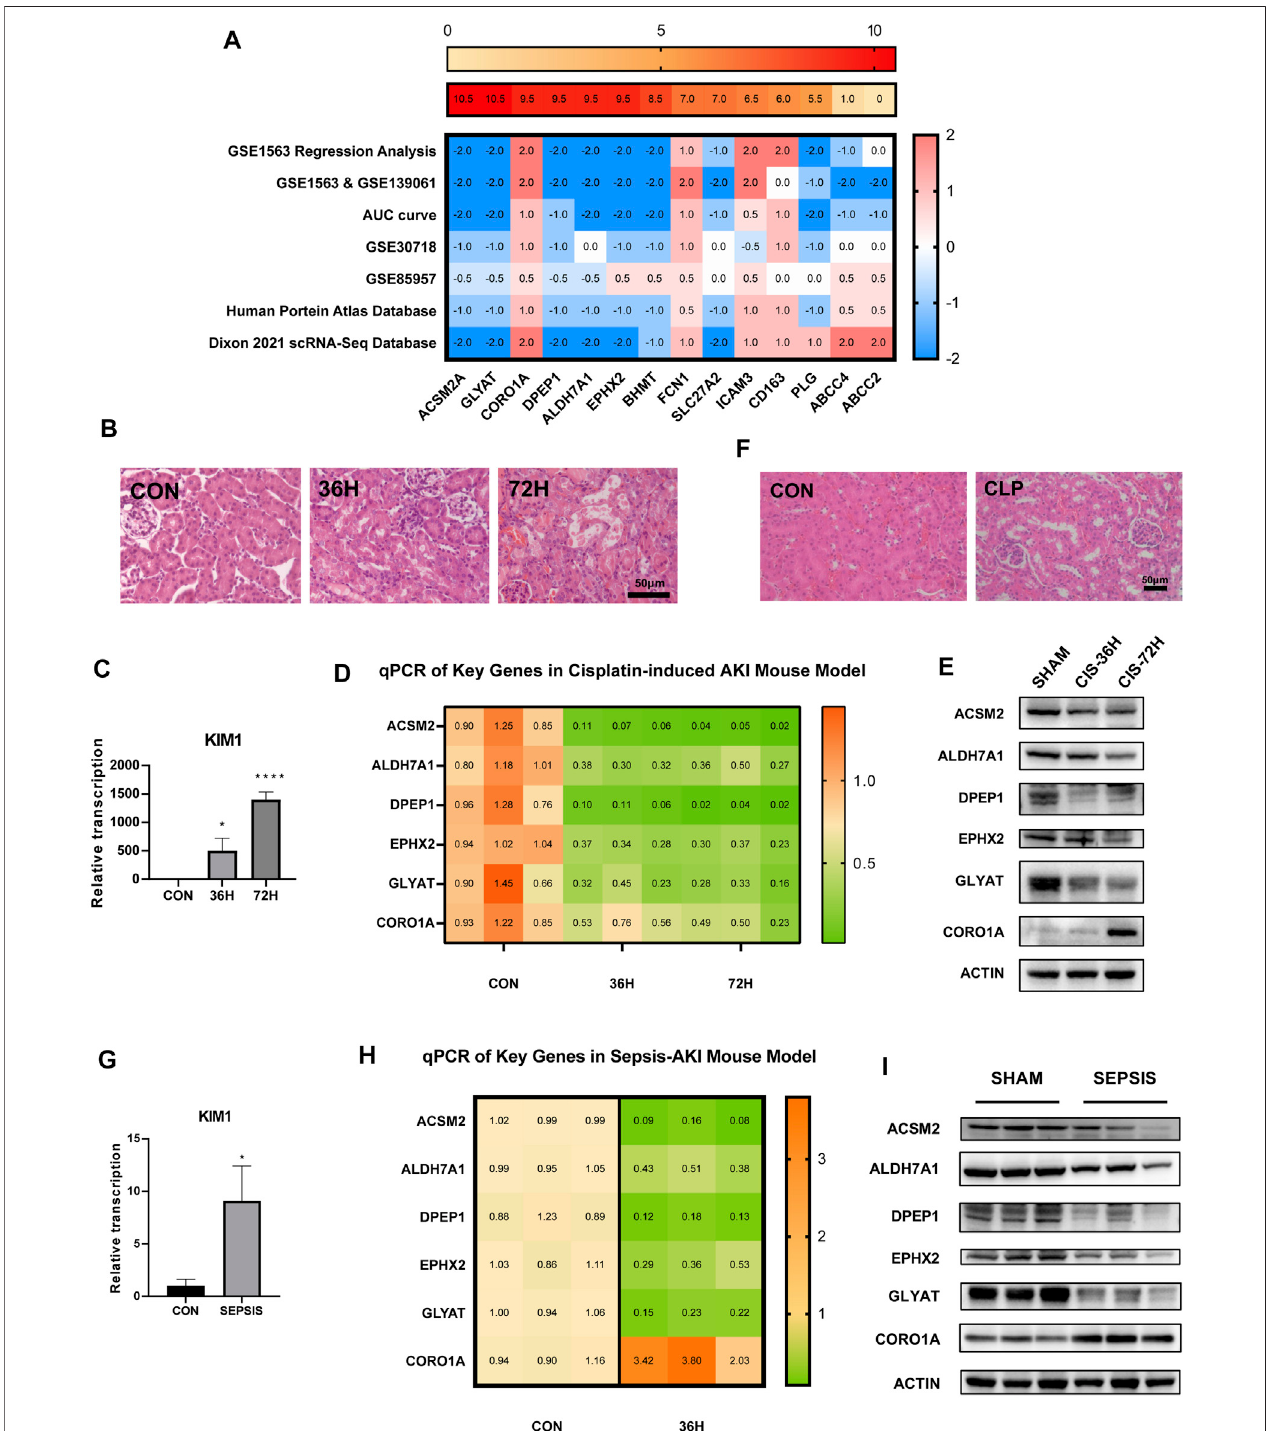
FIGURE 9 | Validation of the mRNA and protein expression of RFRGs. (A) Score of the 14 RFRGs. The aforementioned heatmap shows the total scores of each gene,andtheheatmapbelowshowstheexactscoresofsevenanalyses. (B,C) DegreeofrenalinjurywasmeasuredbyH&EstainingandrelativemRNAlevelsofKIM1of kidney sections from the cisplatin-induced AKI model at different time points. (D,E) Relative mRNA level and representative immunoblot analysis of the top six RFRGs in the cisplatin-induced AKI model at different time points. (F,G) Degree of renal injury was measured by H&E staining and relative mRNA levels of KIM1 of kidney sections from the CLP-induced AKI model at different time points. (H,I) Relative mRNA level and representative immunoblot analysis of the top six RFRGs in the CLP- induced AKI model at different time points. * p < 0.05, ** p < 0.01, *** p < 0.001, and **** p < 0.0001 vs. control group.